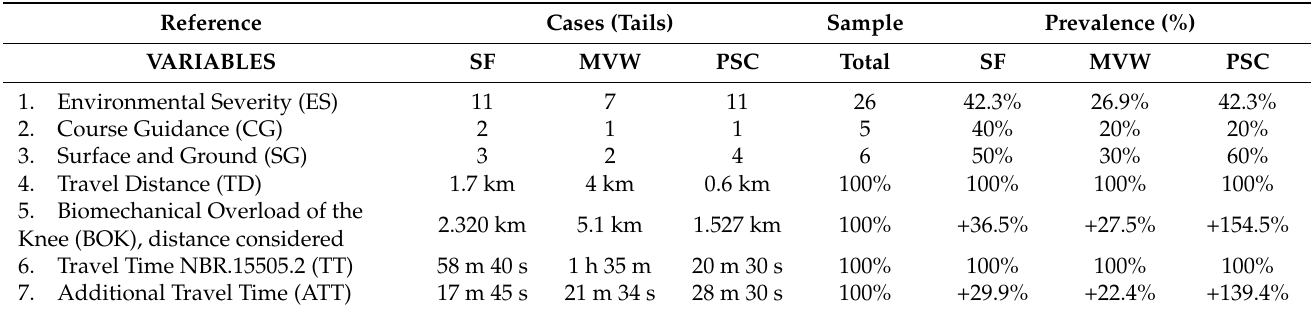
Table 10. Prevalence Matrix of Variables for Network Analysis; Araripe UGG